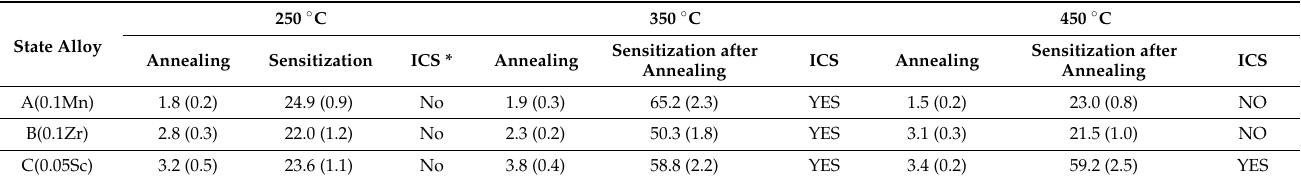
Table 3. ASTM G67 mass loss test of Al-5Mg alloys in annealing and sensitization treatments (mg/cm 2